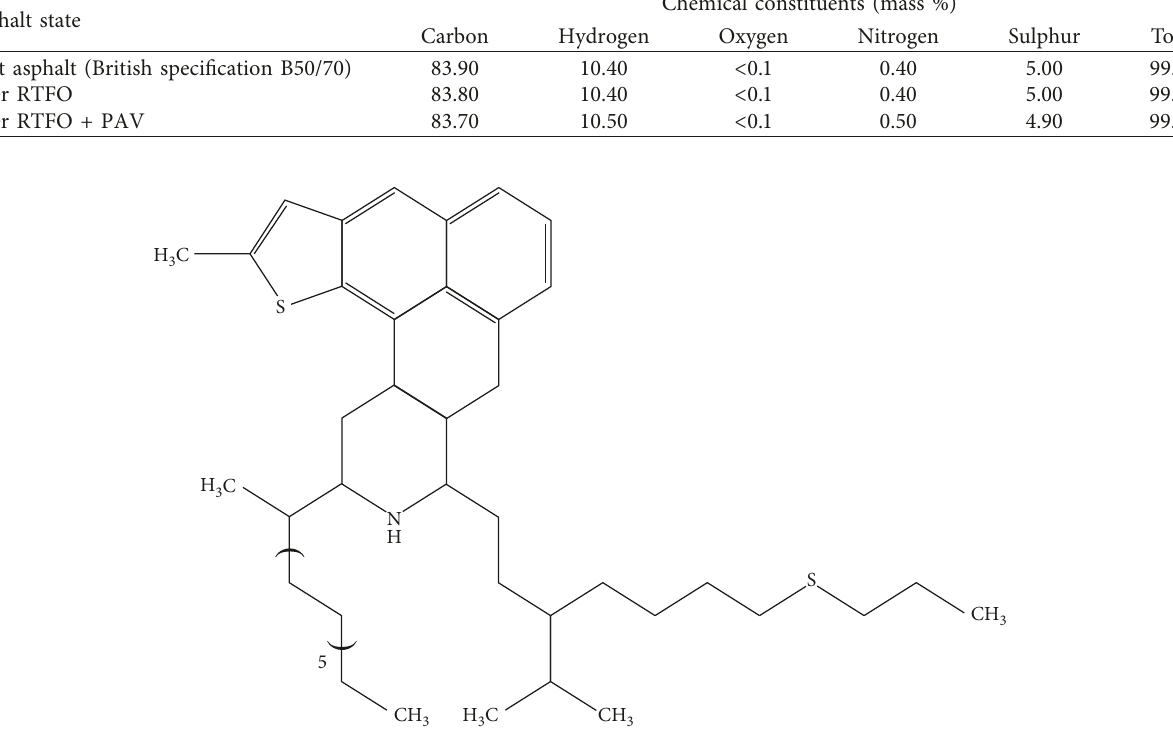
Figure 1: Average structure of California Coastal (aad-1) asphalt molecules. The figure is obtained from Lesueur [10] (under the creative commons attribution license/public domain). Table 2: R f value for asphalt fractions.